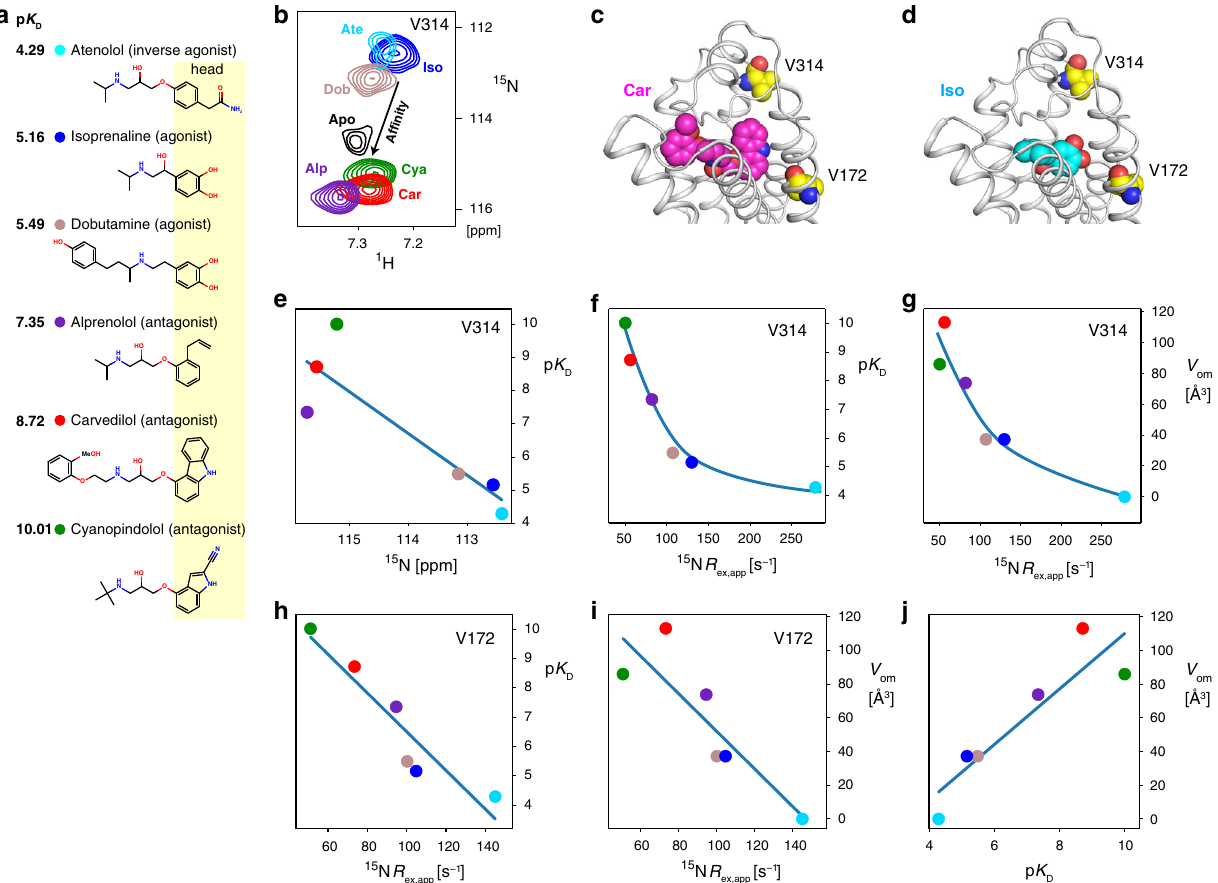
Fig. 3 Correlation of structure and dynamics around the ligand-binding pocket to ligand head group volume. a Chemical structures of the ligands used in the experiments. Ligand af fi nities 58 are indicated as p K D values. b Selected region from 1 H- 15 N TROSYs showing the variation of the V314 6.59 1 H- 15 N resonance in the apo form and orthosteric binary complexes of YY- β 1 AR at 21 T. Spectra are color-coded and marked according to the ligand. Due to limited stability, the apo form of YY- β 1 AR was recorded at 294 K. The arrow indicates the approximate linear correlation between 1 H and 15 N chemical shifts of V314 6.59 in various ligand-bound states and ligand af fi nity (see also Supplementary Fig. 2). c , d Partial views of the β 1 AR crystal structures in complex with carvedilol (4AMJ) and isoprenaline (2Y03) showing V172 and V314 (yellow) in the vicinity of the ligand (magenta, cyan). e – j Correlations of spectral and ligand properties. Lines are drawn to guide the eye. e p K D , V314 6.59 15 N chemical shift. f p K D , V314 6.59 15 N R ex, app . g Volume of ligand head group ortho, meta substitutions ( V om ), V314 6.59 15 N R ex, app . h p K D , V172 4.56 15 N R ex,app . i V om , V172 4.56 15 N R ex, app . j V om , p K D . Numerical data for e – j are provided in Supplementary Data 1, 2.